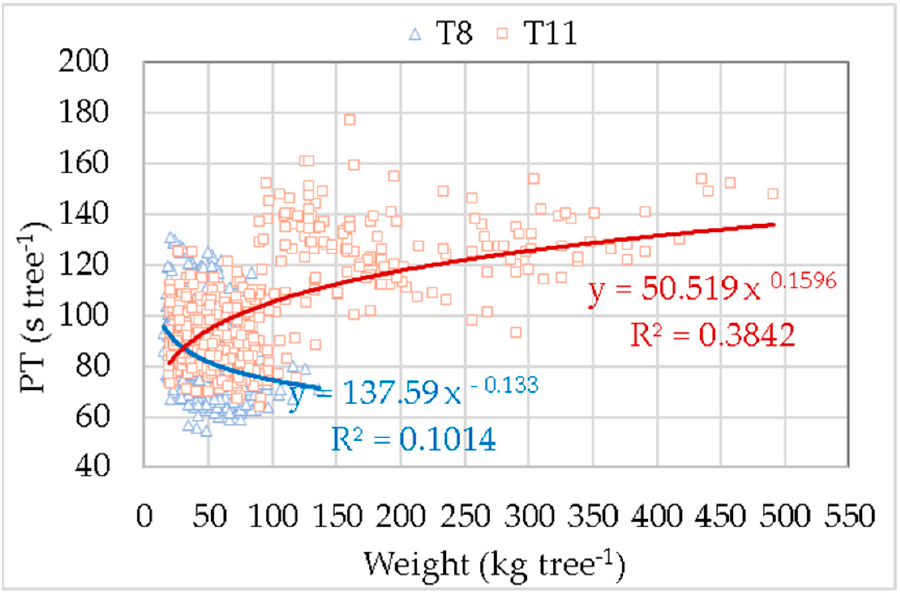
Figure 6. Productive work time ( PT ) as a function of the tree weight for plantations T8 and T11.